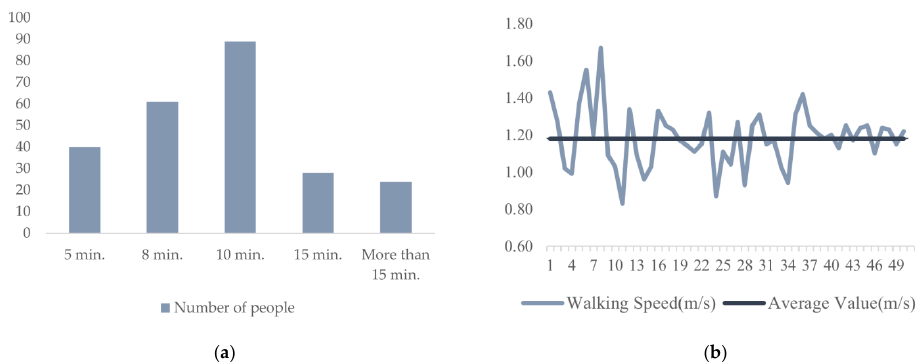
Figure 4. Pedestrian walking time ( a ) and walking speed ( b ) in BDJ station realm.